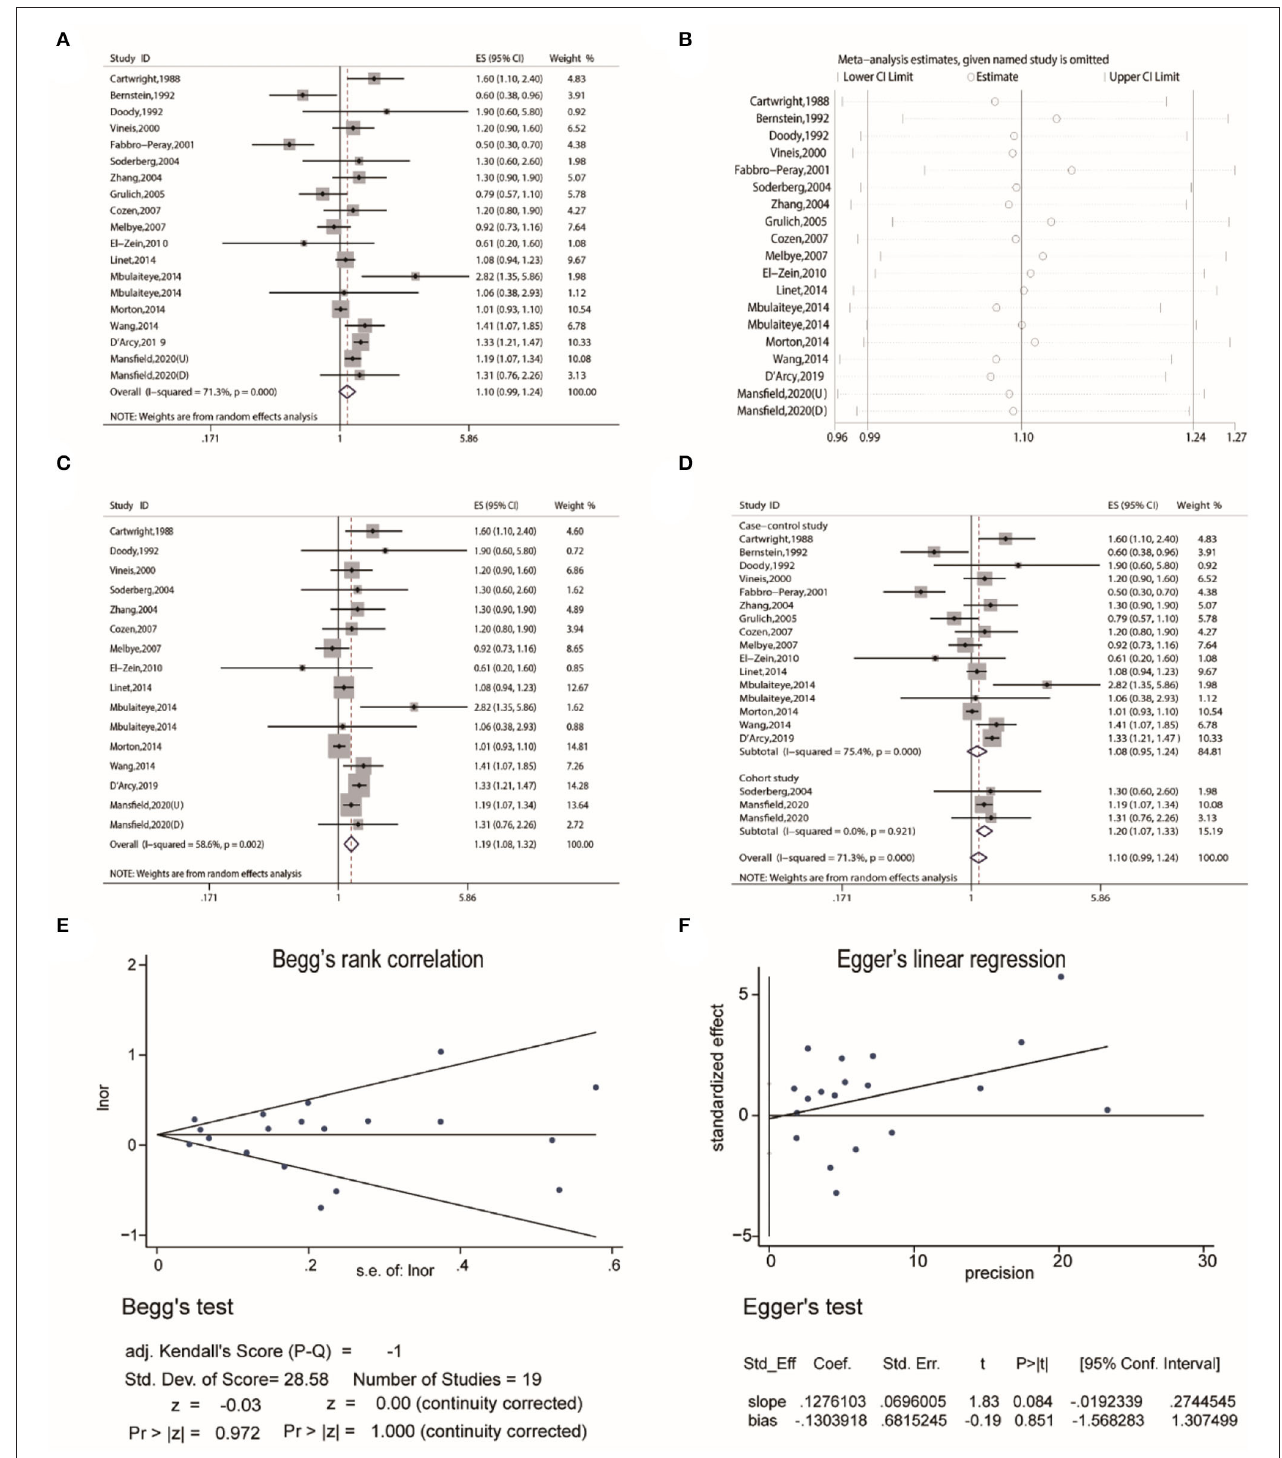
FIGURE 2 | The association between eczema and non-Hodgkin’s lymphoma risk. (A) Forest plot of the estimated effects of eczema on non-Hodgkin’s lymphoma risk. (B) Sensitivity analysis conducted by recalculating the pooled results of the primary analysis following the exclusion of one study per iteration. (C) Sensitivity analysis conducted by recalculating the pooled results of the primary analysis following the exclusion of the Bernstein et al., Fabbro-Peray et al., and Grulich et al. studies. (D) Subgroup analysis of the estimated effects of eczema on non-Hodgkin’s lymphoma risk by study design. (E) Begg’s test indicating the lack of publication bias among such studies. (F) Egger’s test indicating the lack of publication bias among such